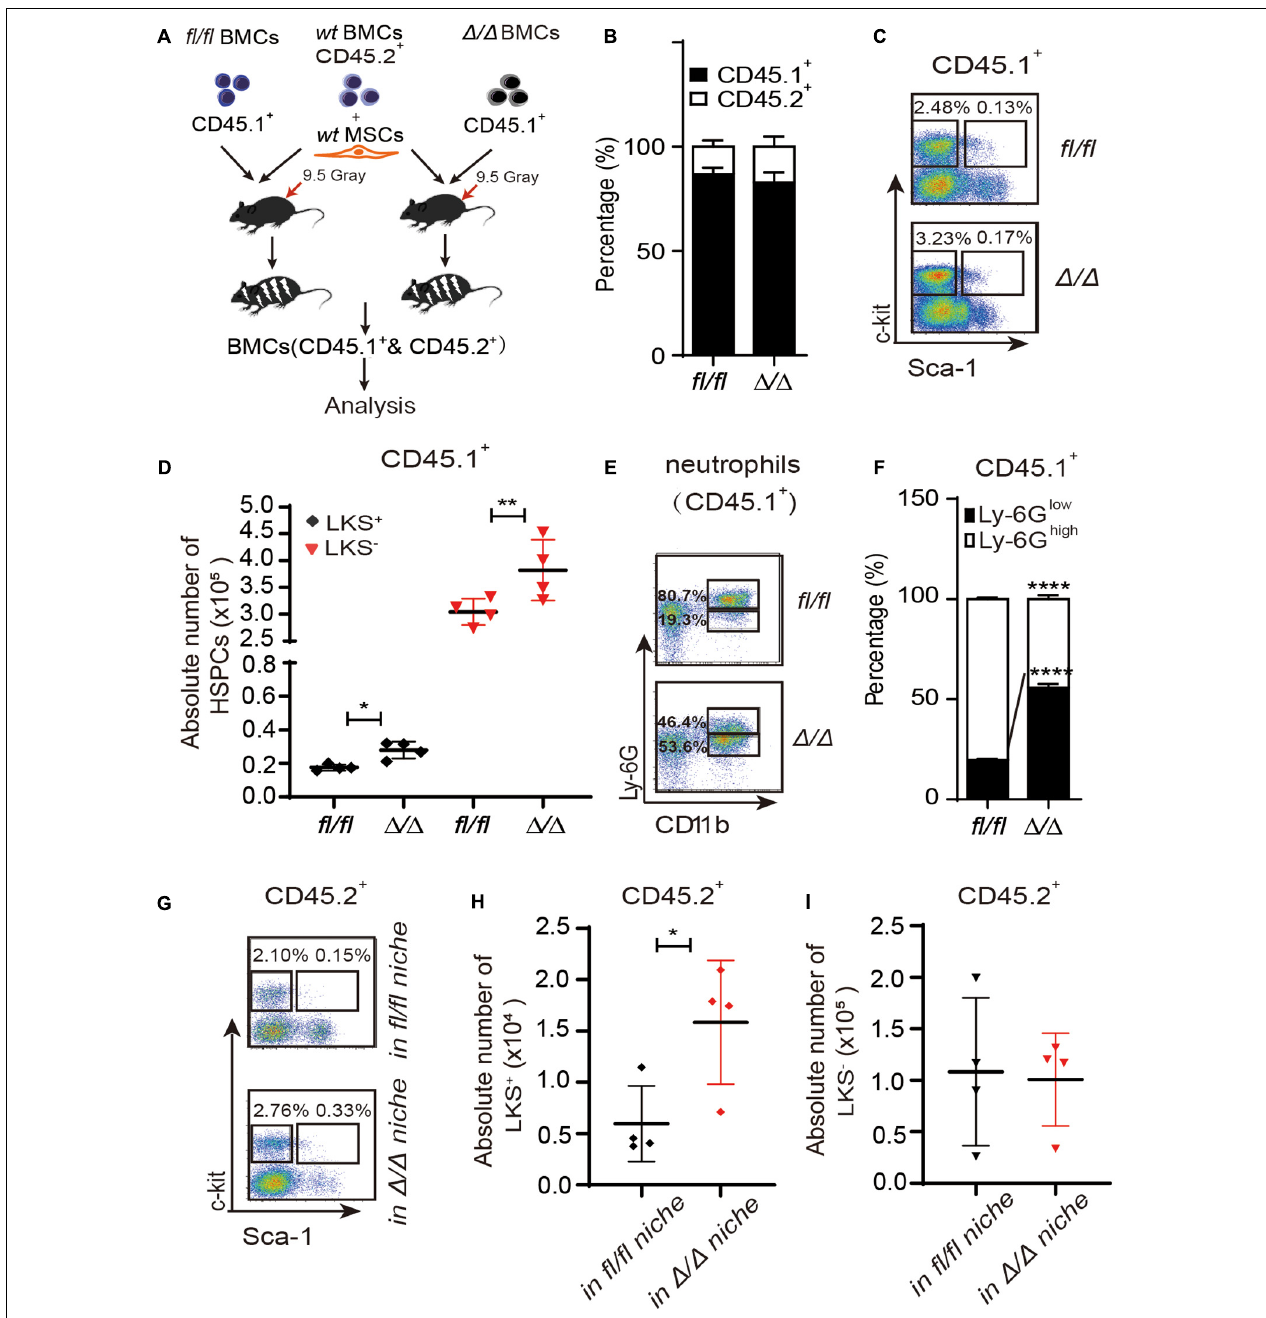
FIGURE 1 | HSPCs are expanded in the Rheb1 (cid:49)/(cid:49) blood cell-remodeled bone marrow environment. (A) WT BMCs (CD45.2 + ) together with wt MSCs and Rheb1 (cid:49)/(cid:49) or Rheb1 fl / fl BMCs (CD45.1 + ) were transplanted into lethally irradiated recipient wt mice. (B) The percentages of CD45.1 + cells and CD45.2 + cells in BM 4 months after transplantation. (C,D) The absolute number of CD45.1 + LKS + cells and CD45.1 + LKS − cells in BM 4 months after transplantation. (E,F) The percentages of CD45.1 + CD11b + Ly-6G high / low neutrophils in BM 4 months after transplantation. (G–I) The absolute number of CD45.2 + LKS + cells and CD45.2 + LKS − cells in BM 4 months after transplantation. The data are presented as the mean ± SD, n = 4. * P < 0 . 05; ** P < 0 . 01; *** P < 0 . 001.